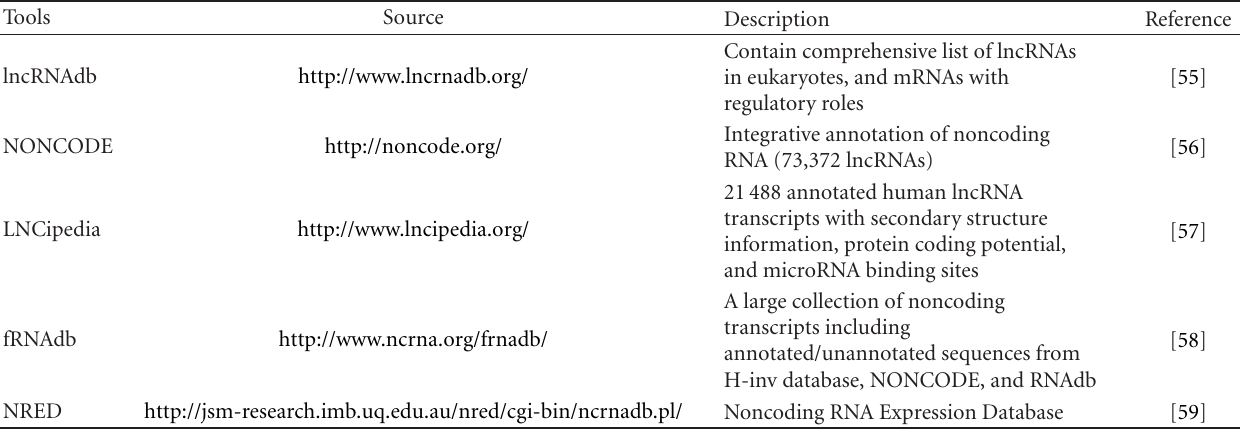
Table 3: List of lncRNA